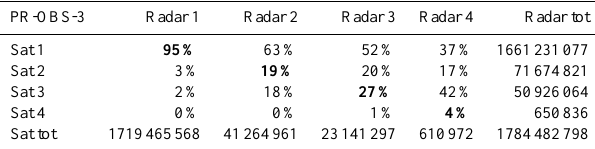
Table 15. Contingency table for the multi-categorical statistics for PR-OBS-3 as compared with rain gauge-derived rain fields.